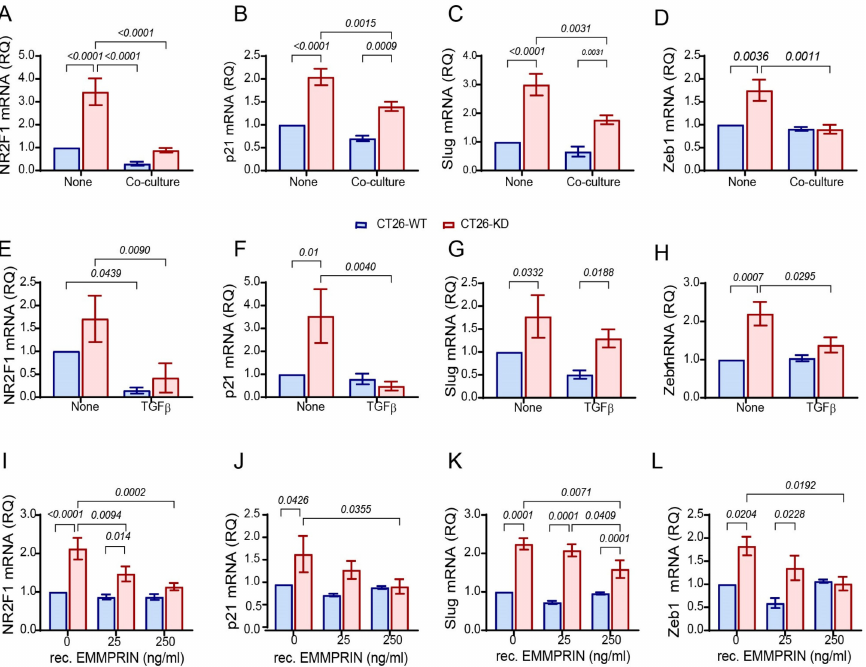
Figure 4. Expression of the EMT-TFs and dormancy markers is enhanced in the CT26-KD cells, but reduced in the co-culture or its simulation. CT26-WT or CT26-KD cells (8 × 10 4 cells each) were incubated alone or in co-culture with RAW 264.7 cells as described before for 48 h. Alternatively, single cultures of CT26-WT or CT26-KD cells (8 × 10 4 cells) were cultured with or without the addition of recombinant TGF β (10 ng/mL) or recombinant EMMPRIN (25 ng/mL or 250 ng/mL). Total RNA was extracted from the CT26 cells, cDNA was prepared, and the genes for the dormancy markers NR2F1 and p21 or the EMT-TFs Slug and Zeb1 were amplified by qPCR as described in the methods. ( A – D ) cells incubated in co-cultures ( n = 5–6), ( E – H ) single cultures incubated with the addition of TGF β (10 ng/mL) ( n = 5–6), and ( I – L ) cells incubated with the addition of recombinant EMMPRIN (25 and 250 ng/mL) ( n = 5). Data are presented as means ± SE, and analyzed using a two-way ANOVA followed by Bonferroni’s post-hoc